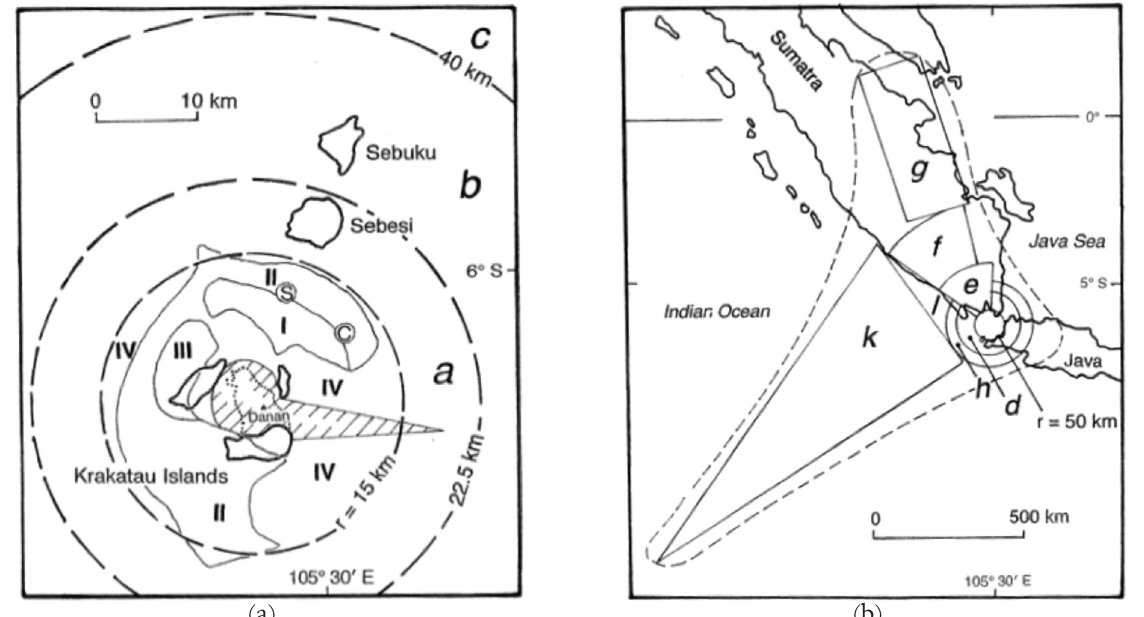
Figure 2. Division maps of Verbeek’s survey of ejecta in and around the Sunda Straits. (a) Survey divisions of the inner area of Krakatau Is- lands: a simplified map of Verbeek’s figure [1885, fig. 4]. Pieces I ~ IV are within a circle of 15 km radius around Krakatau Islands, and Rings b , c and d successively continue to Ring a . ⓢ and ⓒ denote Steers and Calmeyer reefs, respectively. A hatched area is the caldera depres- sion; Verbeek’s method is not applicable there. (b) Survey divisions in the outer area of Krakatau Islands. The innermost circle (r = 50 km) includes Rings a , b , c and Pieces I ~ IV shown in Figure